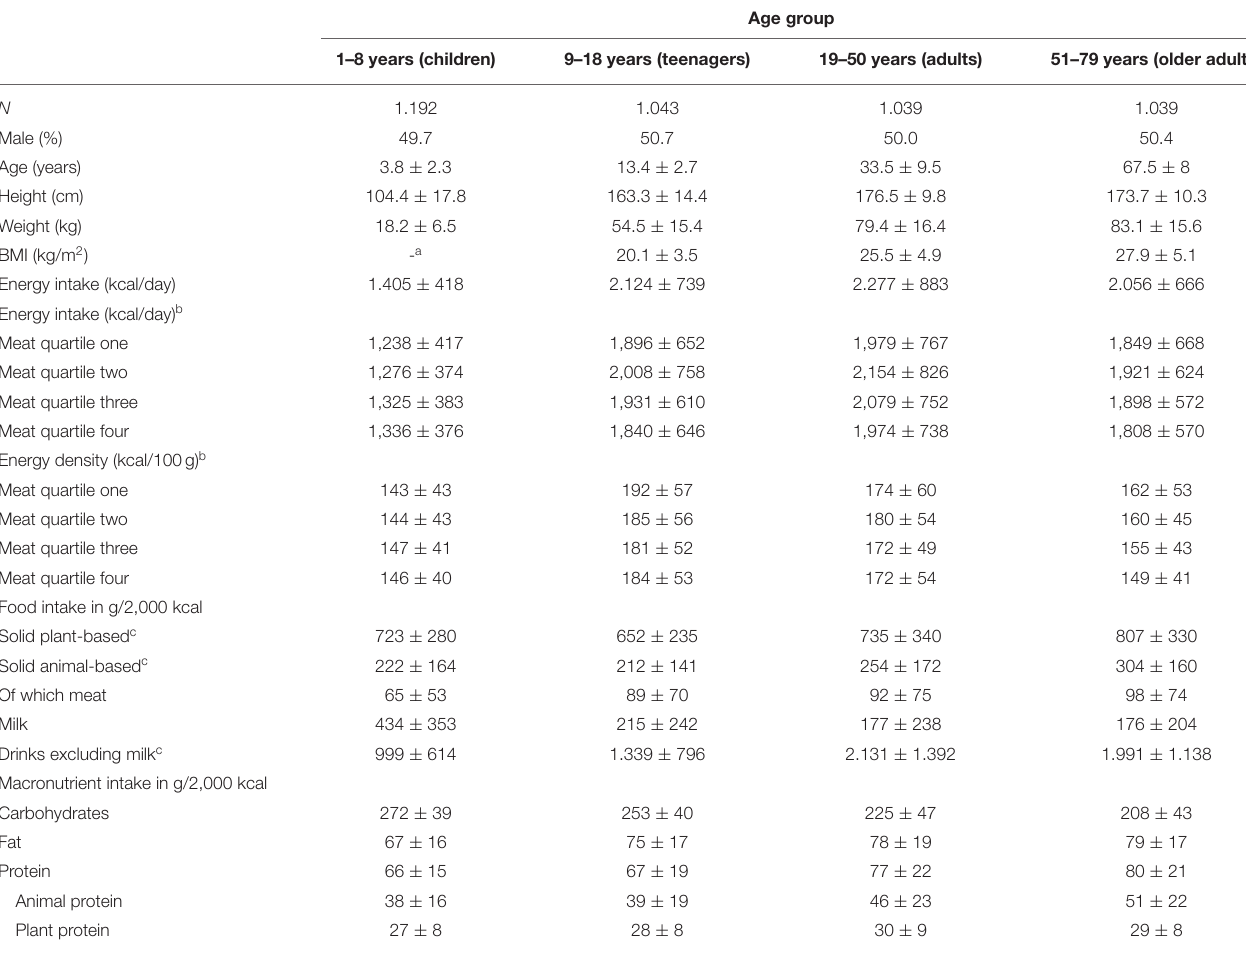
TABLE 1 | Population characteristics, energy intake (kcal), energy density (kcal/100g), animal- and plant-based food intake (g/2,000 kcal), and macronutrient intake (g/2,000 kcal) per age